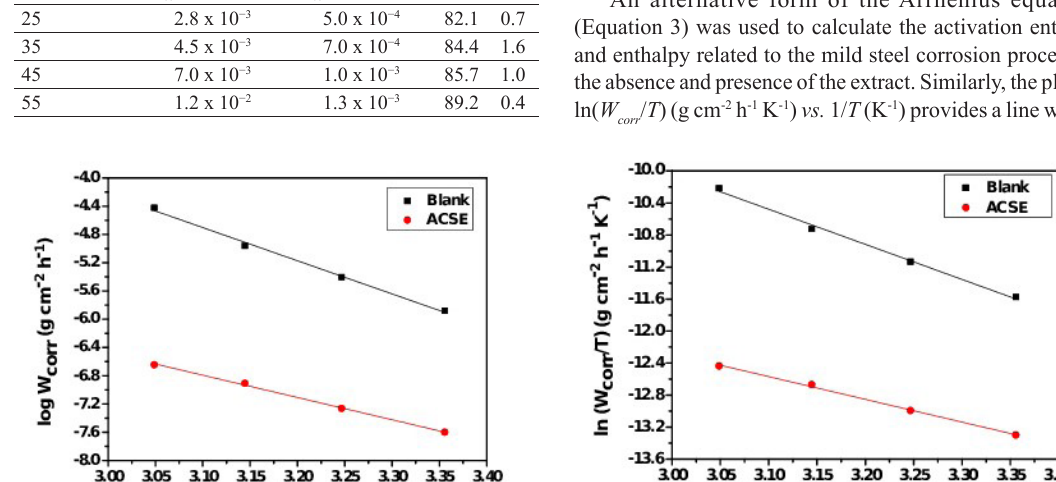
Table 2. Temperature effect on the corrosion of mild steel in 1 mol L -1 HCl in the absence and presence of ACSE. Blank Temperature (°C)